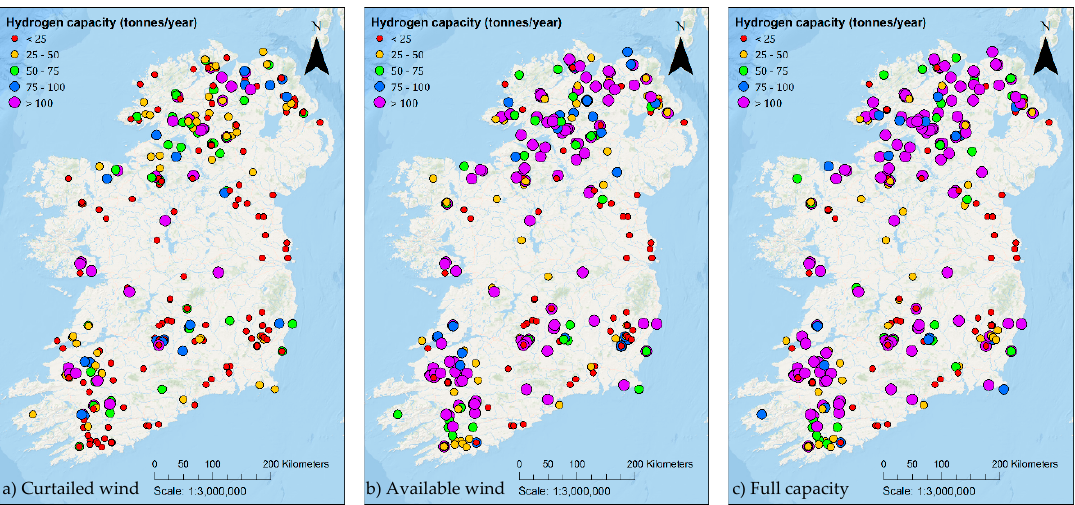
Figure 8. Capacity of annual hydrogen production ( M H2 ) with current parameters of (a) curtailed wind operation, (b) available wind operation, and (c) full capacity operation, calculated by the techno-economic submodel for all wind farms in the island of Ireland.